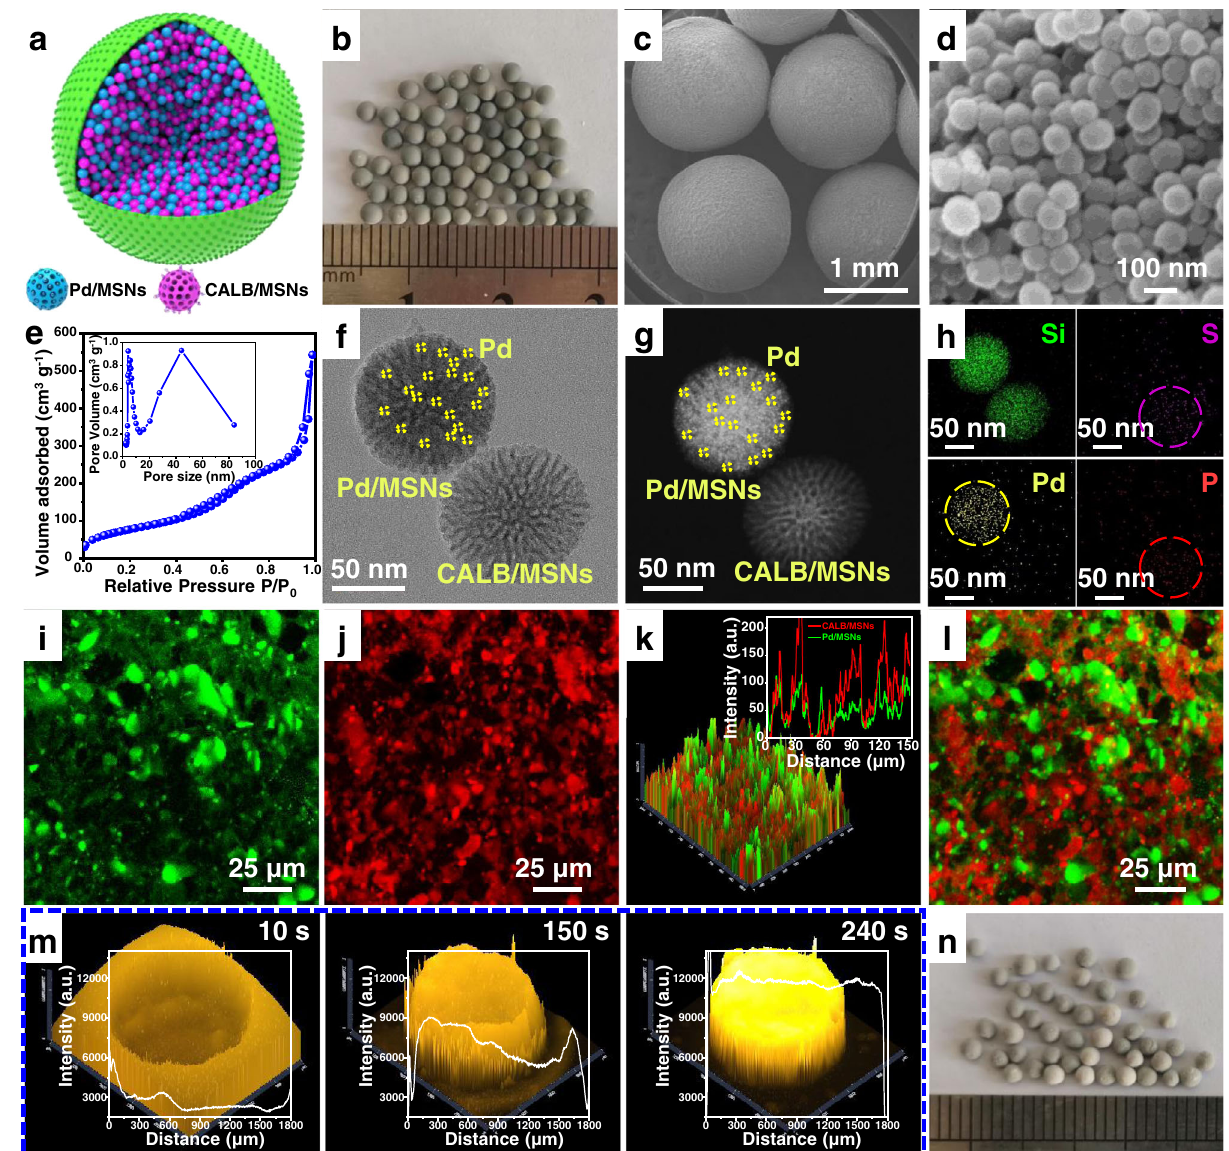
Fig. 4 | Characterization of the SP-based cascade catalyst. a Structural illus- tration of the microstructures of Pd-CALB/SPs. b Appearance of Pd-CALB/SPs. c SEMimageshowingPd-CALB/SPs. d SEMimageshowingtheinteriorstructure of Pd-CALB/SPs. e N 2 adsorption-desorption isotherms of Pd-CALB/SPs (the inset is the pore size distribution plot). f High-resolution TEM image showing thebuildingblockswithinPd-CALB/SPs. g High-resolutionTEMimageshowing thebuildingblockswithinPd-CALB/SPs. h Elementalmapping oftheinteriorof Pd-CALB/SPs. i Fluorescence confocal microscopy image of Pd-CALB/SPs with Pd/MSNs labelled by FITC-I. j Fluorescence confocal microscopy image of Pd-